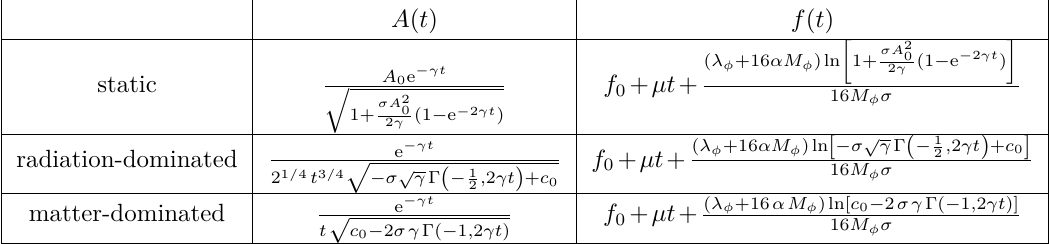
Table 1 . Solutions for the condensate evolution in a static, radiation-dominated, and matter- dominated universe. The constants A 0 , c 0 , and f 0 can be determined by the initial conditions for ϕ and ˙ ϕ